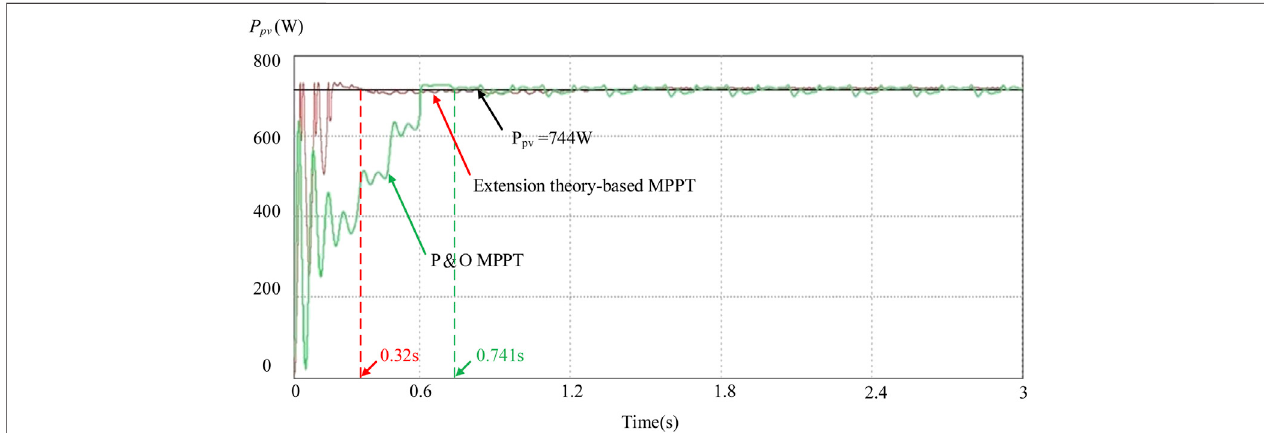
FIGURE 8 | Simulation waveforms of the MPPT using the P&O and extension theory-based method when sunshine is 1,000 W/m 2 .